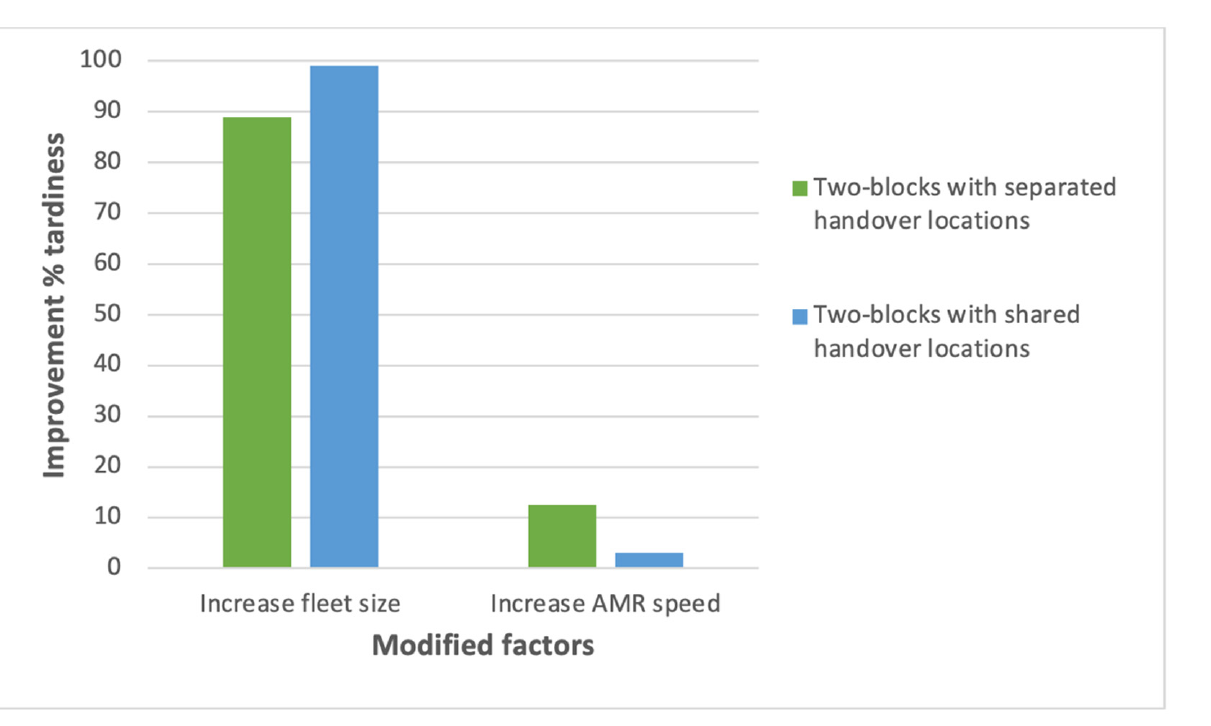
Figure 9. Tardiness improvement for different solutions.